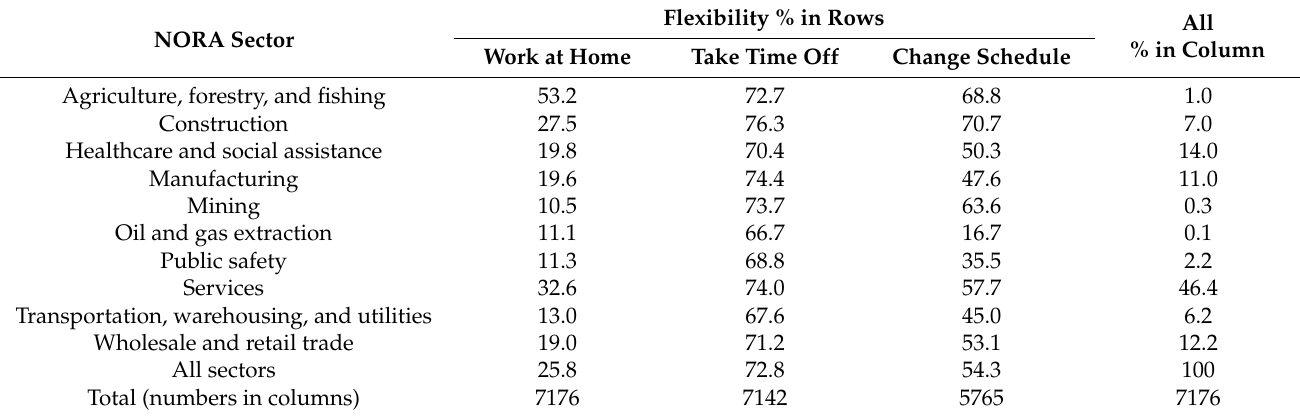
Table 3. Flexibility by NORA industry sector, pooled GSS-QWL data.